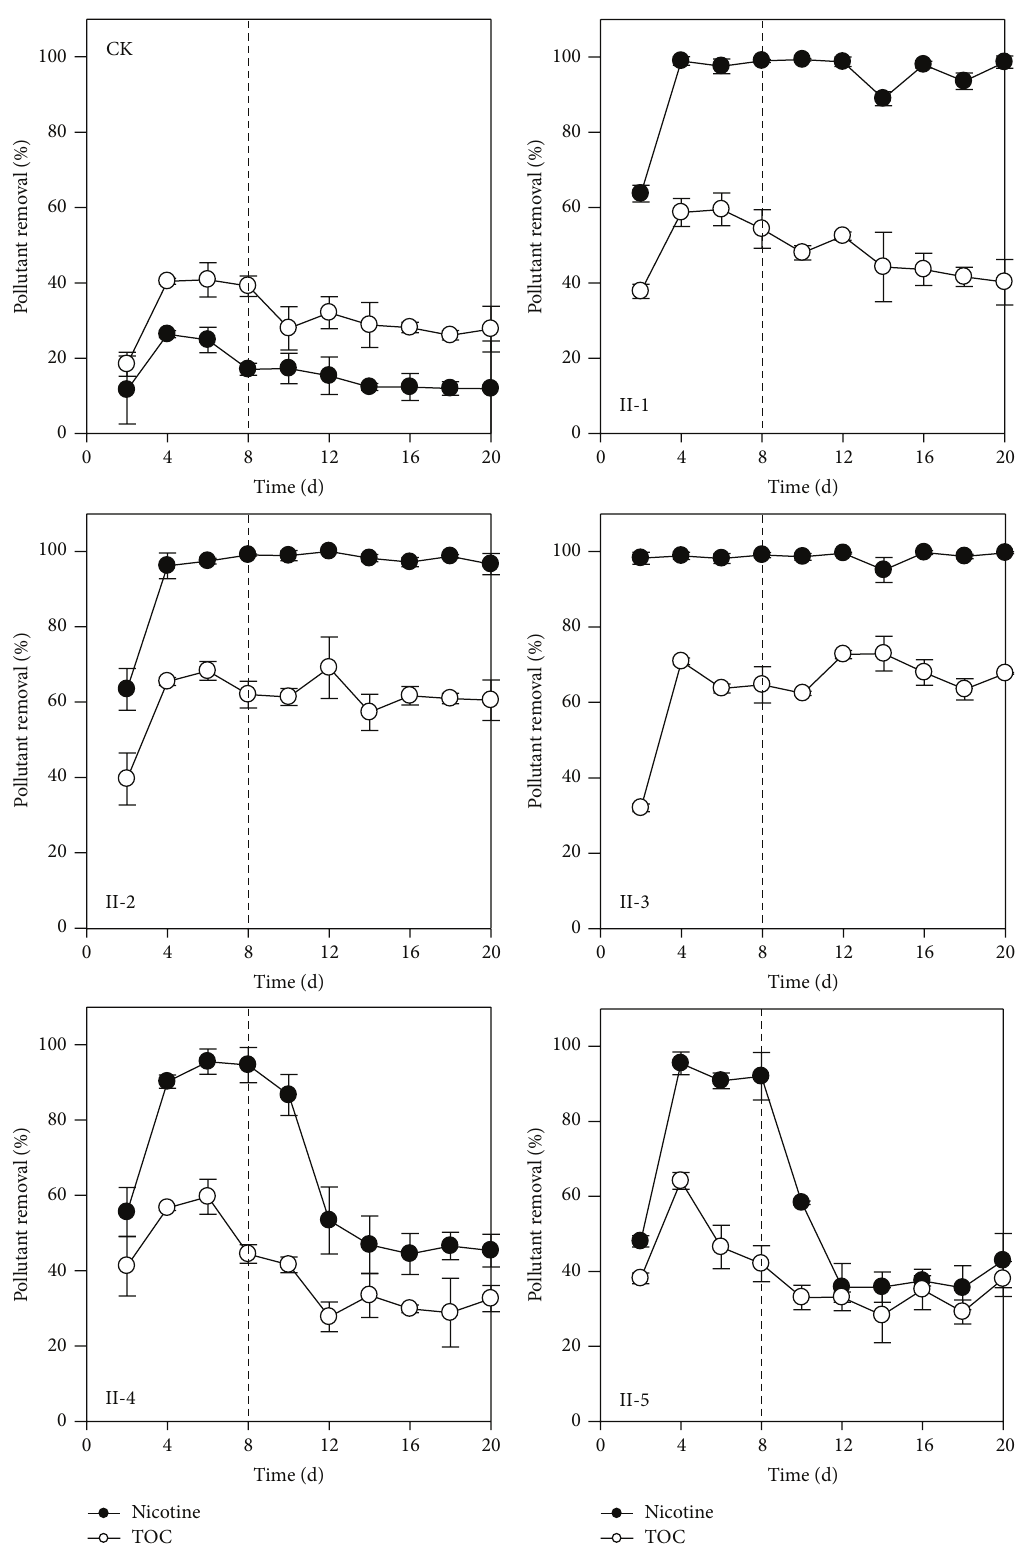
Figure 4: Effect of initial pH on pollutant removal in tobacco wastewater. The initial pH in reactor II-1 to II-5 was 5.0, 6.0, 7.0, 8.0, and 9.0, respectively. CK: noninoculated